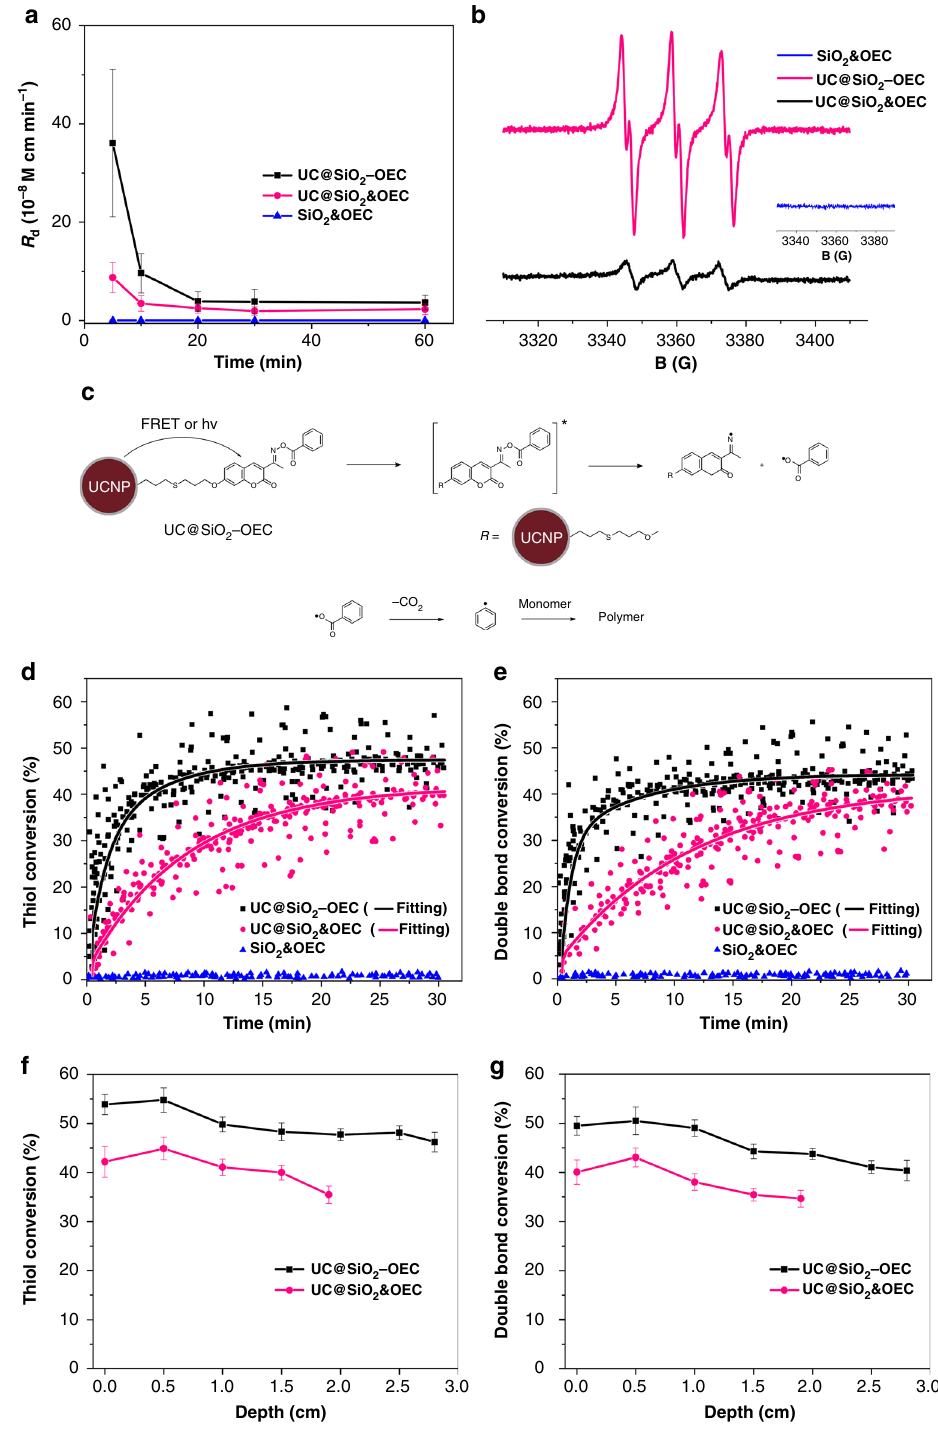
Fig. 2 The photochemical properties of dandelion-like NIR light PIs. a The photolysis kinetics curves of UC@SiO 2 -OEC, UC@SiO 2 &OEC and SiO 2 &OEC. The